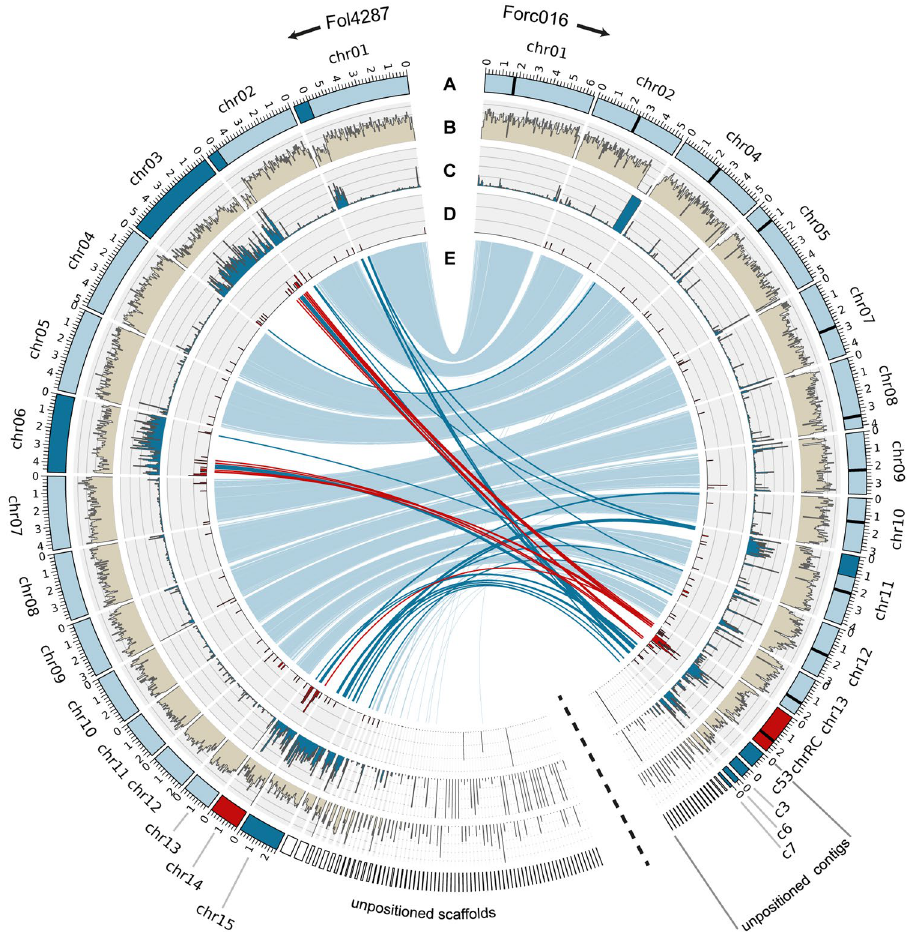
Figure 2. The SMRT genome assembly of Forc016 includes eleven core chromosomes, several repeat-rich, gene-poor accessory regions and one chromosome enriched in candidate effector genes. Comparison of the Forc016 assembly to that of Fol4287 reveals ( A ) eleven conserved core chromosomes (light blue), one putative pathogenicity chromosome (red) and several other accessory sequences (dark blue). Accessory regions typically have ( B ) low gene density and ( C ) high repeat density, both calculated here in 50 kb windows. The putative pathogenicity chromosome is marked by ( D ) the presence of many candidate effector genes. ( E ) Indicates nucmer alignments with the Fol4287 reference assembly: in red alignments to the putative pathogenicity chromosome of Forc016, in dark blue alignments from known accessory regions in Fol4287 (chr1B; chr2B; chr3; chr6; chr14; chr15) and in light blue the remaining alignments, mostly between core regions in both